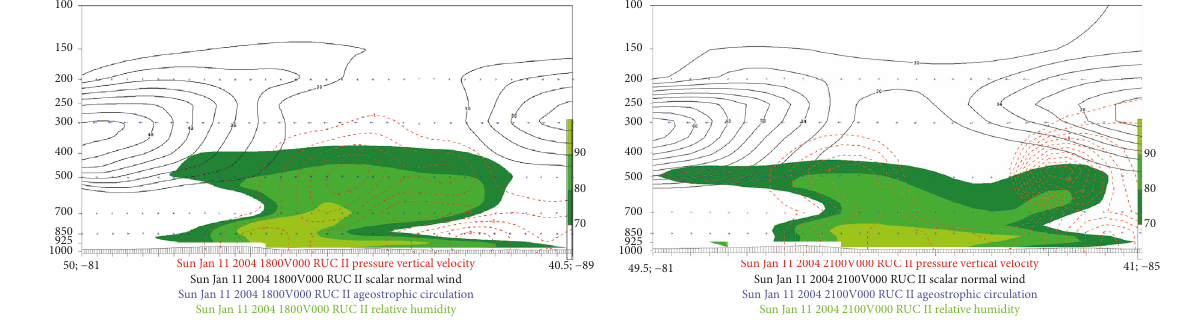
(b) As in Figure 7(a), except valid at 2100 UTC 11 January 2004